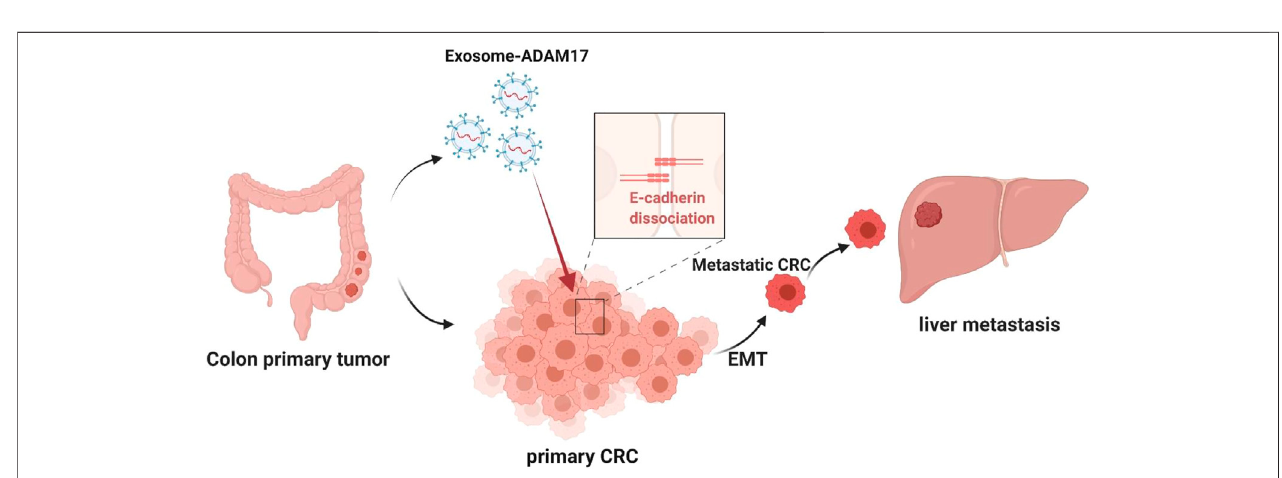
FIGURE 6 | Proposed mechanism for exosomal ADAM17-mediated promotion of CRC metastasis. The CRC-derived exosomal ADAM17 promoted the E-cadherin cleavage, enhancing the migratory properties of CRC cells, which in turn promoted hepatic metastasis in vivo .